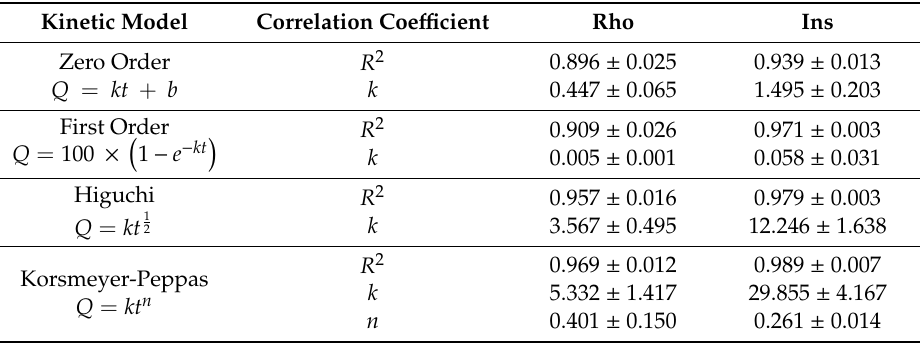
Figure 1. Cumulative in vitro release profiles and kinetic modeling of rhodamine 123 (Rho) and insulin (Ins)-loaded lipid-core micelles, performed at 37 °C, in simulated physiological conditions with PBS pH 7.4. Values are represented as mean ± standard deviation of three different batches ( n = 3). * indicates statistical differences at the same comparison level by t -test ( p < 0.05). The kinetic modeling parameters and the adjusted R 2 values for all release profiles are shown in Table 2. The release profiles of Rho and Ins from LCMs are better fitted by the Korsmeyer–Peppas model ( R 2 = 0.969 ± 0.012 and R 2 = 0.989 ± 0.007, respectively). The similarity factor of both profiles was calculated ( f 2 = 21.6) resulting in evidently di ff erent profiles. Table 2. Kinetic modeling parameters and adjusted correlation coefficient ( R 2 ) for in vitro release profiles of rhodamine 123 (Rho) and insulin (Ins)-loaded lipid-core micelles, performed at 37 °C. Values are presented as mean ± standard deviation ( n = 3).